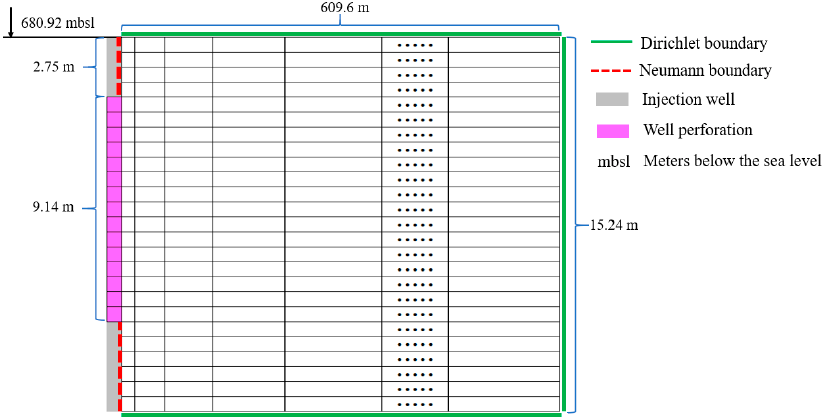
Figure 5. Conceptual model, discretization and boundary